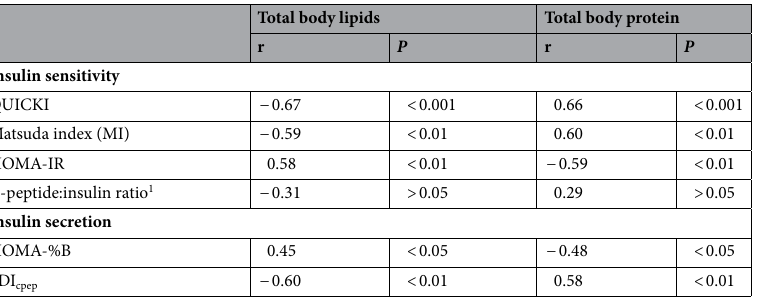
Table 4. Correlations between body composition and insulin sensitivity and secretion indexes estimated from the oral glucose tolerance test (trial 1; n = 24). QUICKI quantitative insulin sensitivity check index, oDI cpep oral disposition index, HOMA-IR homeostasis model assessment for estimating insulin resistance, HOMA-%B homeostasis model assessment for estimating β-cell function. 1 AUC C-peptide/AUC